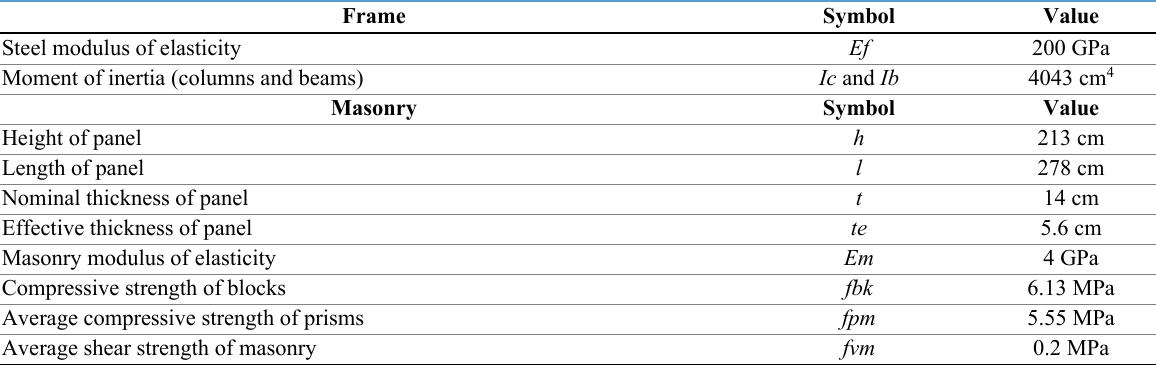
Table 1. Material properties of experimental tests from De Grandi